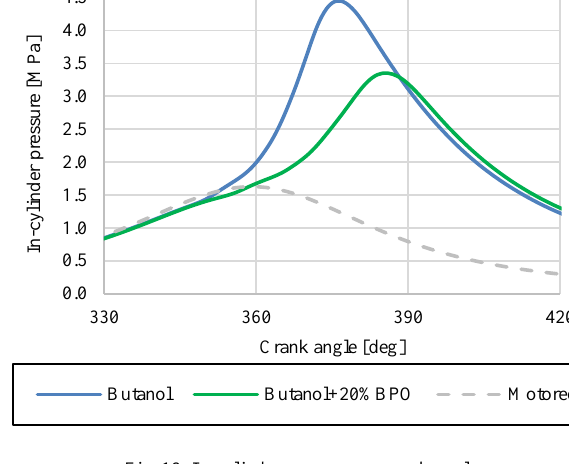
Fig. 13. In-cylinder pressure vs. crank angle